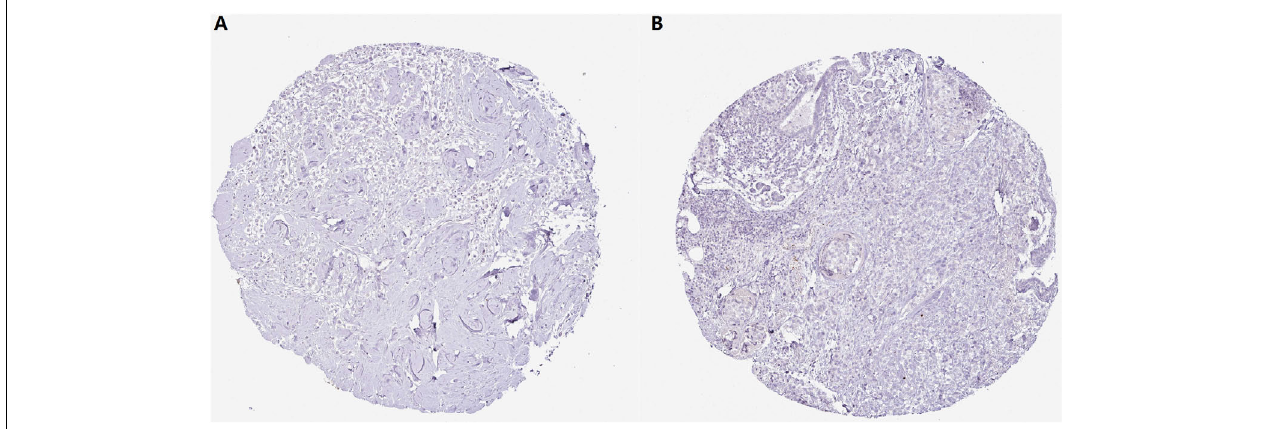
FIGURE 7 | Representative immunohistochemical staining of CMTM5 in breast cancer tissue samples from the Human Protein Atlas database (original magnification 50 × ). (A) Invasive ductal carcinoma (staining: not detected, intensity: negative, and quantity: none). (B) Invasive lobular carcinoma (staining: not detected, intensity: negative, and quantity: none).